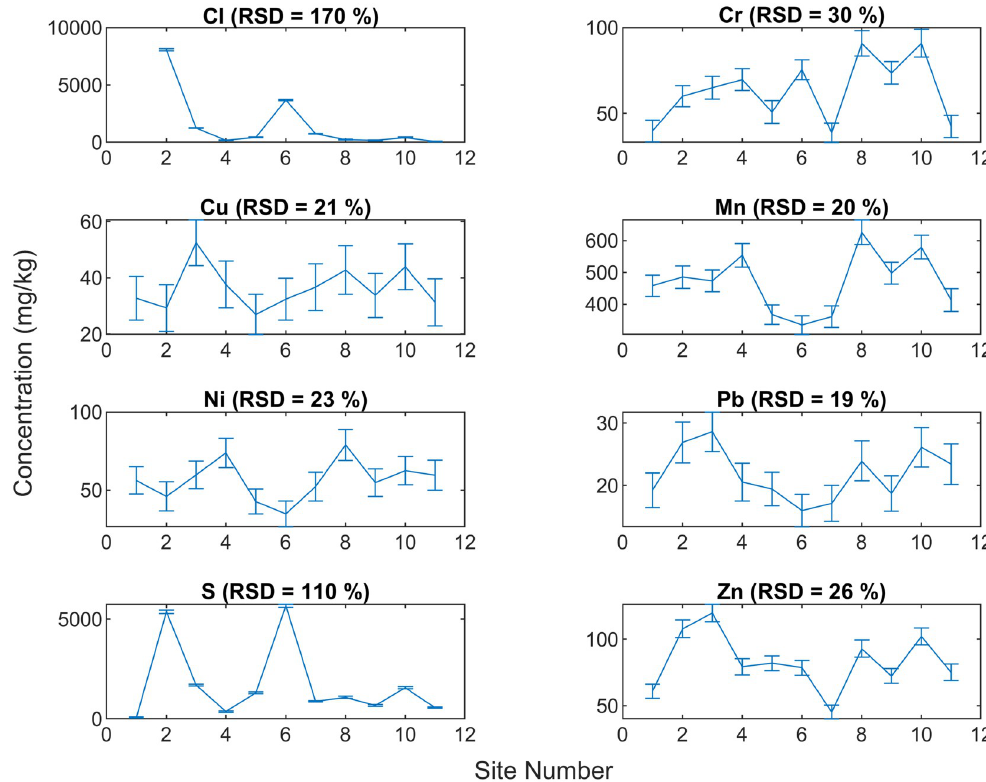
Fig 6. Elemental concentration in soils across eleven sites in IIT Delhi